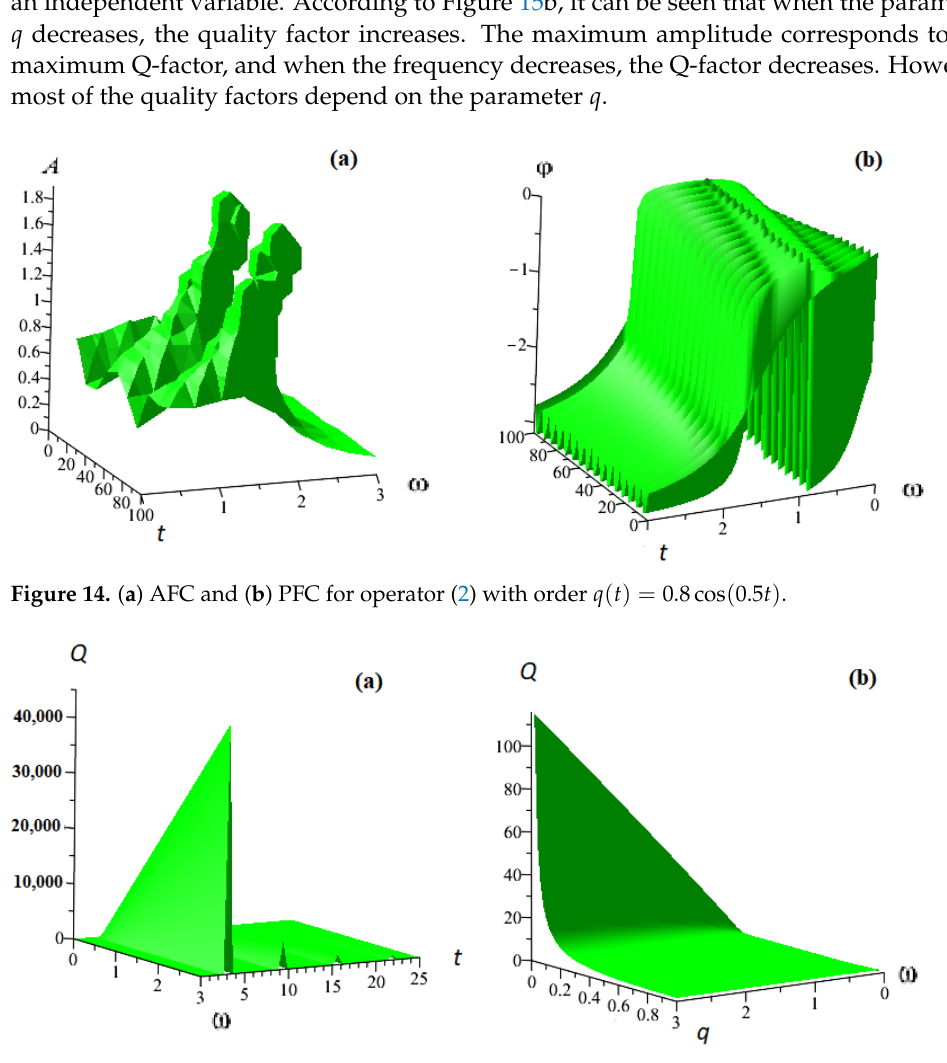
Figure 15. Q factor: ( a ) q ( t ) = 0.8cos ( 0.5 t ) , ( b ) for q ∈ [ 0,1 ]